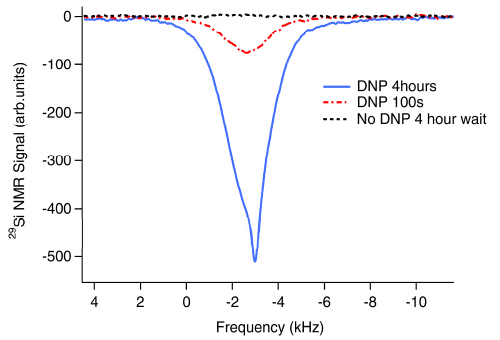
Figure 13. 29 Si NMR spectra acquired at 1.4 K for different microwave irradiation times in B = 2.35 T ( f 0 = 19.89 MHz). The spectrum acquired without the microwave irradiation is shown using the dashed line. (Reprinted figure with permission from Reference [51] © (2008) by the American Physical Society).